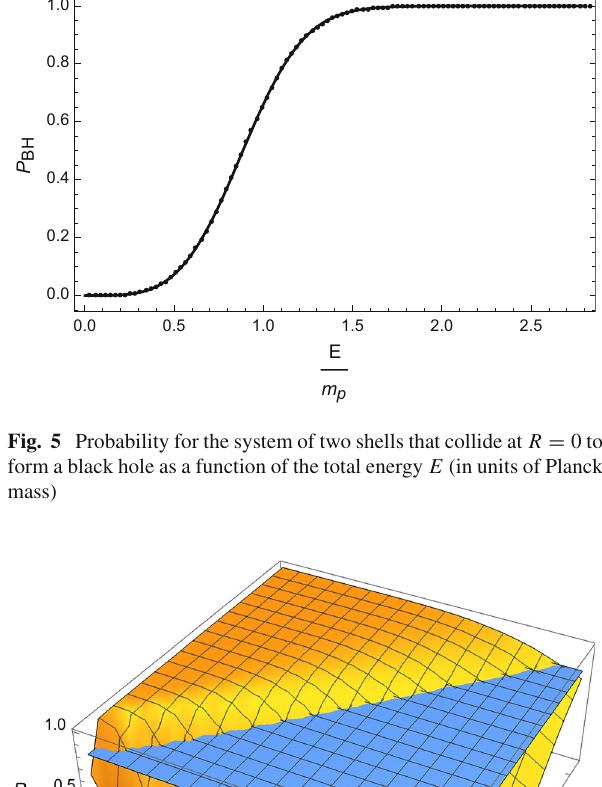
15 m p . The plot on the top right represents a slice of the three-dimensional plot where the total energy is constant and equal to